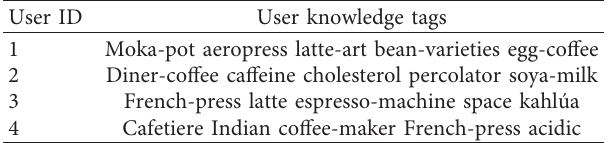
Table 2: Stack Exchange dataset statistics. Table 1: User knowledge Tags descriptions.